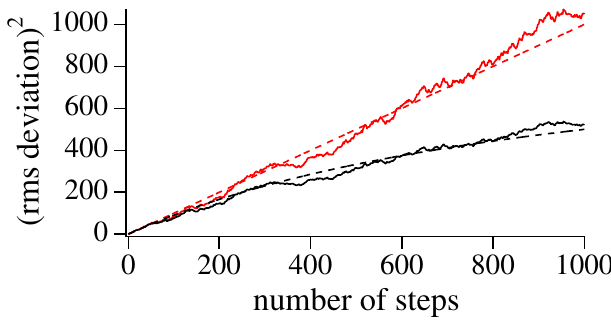
FIG. 19. (Color) The red curves show the case with the constant kick strength throughout the process and the black curves show the case with the kick strength decreasing as 1 curves are simulation results and the dashed curves are the model of random